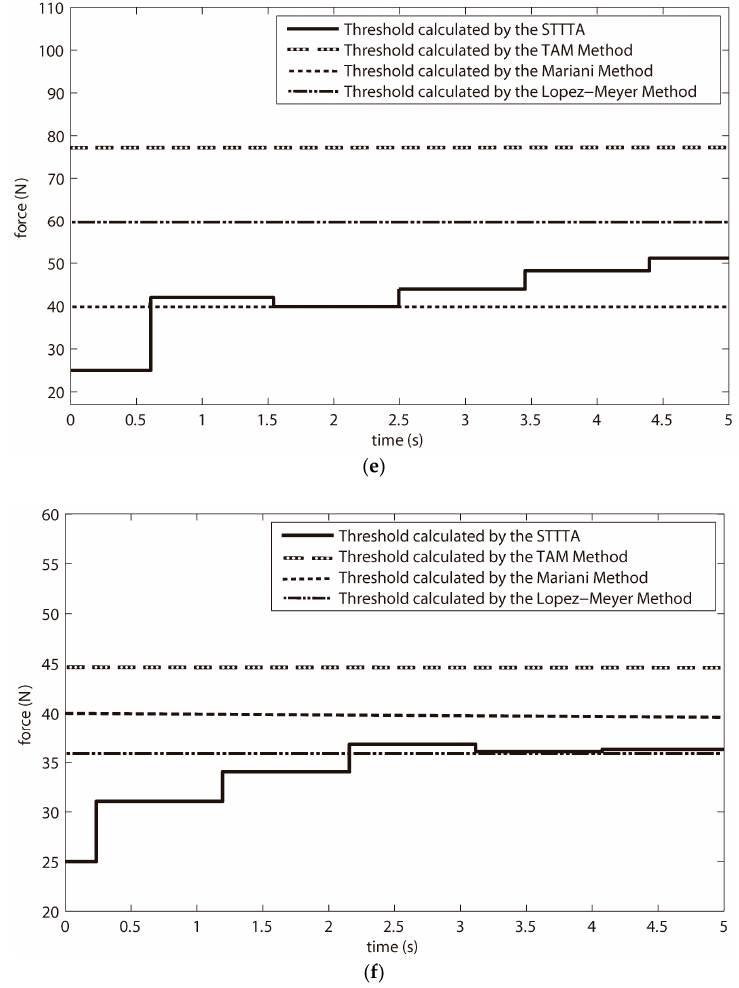
Figure 4. ( a ) the GCFs of heel and ball measured by FSRs; ( b ) three self-tuning thresholds for